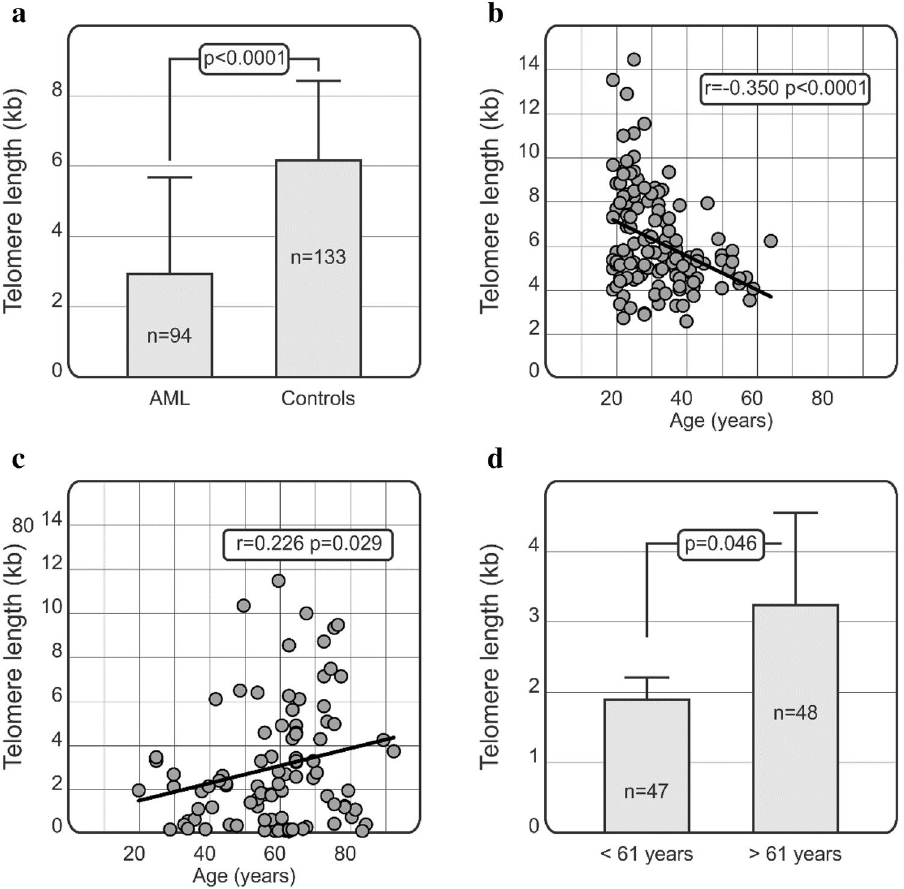
Figure 1. Comparison of telomere length in AML patients and controls ( a ) and relationships between age and telomere length in patients and controls. Telomere length correlates negatively with age in healthy controls ( b ) but not in AML patients ( c ). Statistical analysis was performed using Pearson correlation (PC) tests. Comparison of telomere length in AML patients below and above 61 years of age. Mann-Whitney U test was employed to assess the significance of differences in telomere length ( d